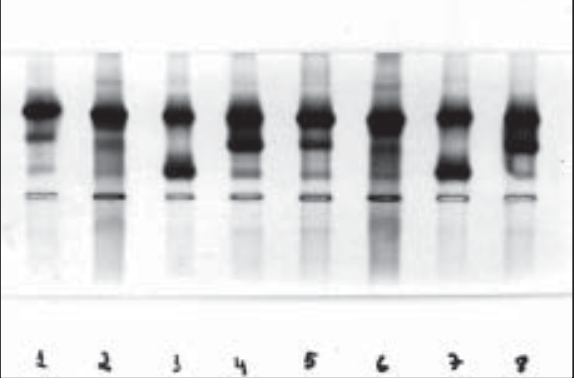
Figure 3 – Hemoglobin electrophoresis: 1 and 5: Hb A + Lepore; 3 and 7: Hb AC; 4 and 8: Hb AS; 2 and 6: unstable Hb. Source: C.D.A. Naoun Laboratórios de Análises